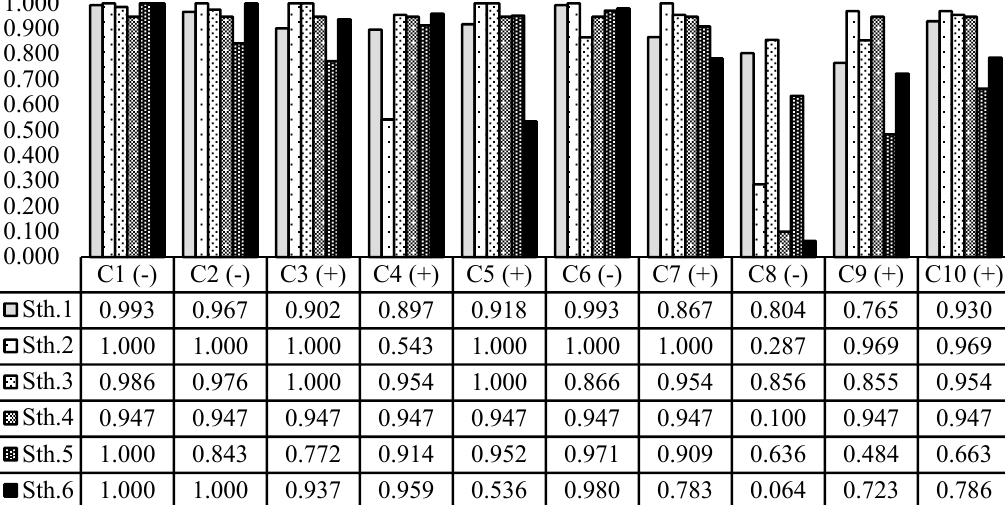
Figure 7. The defuzzified weights of the selected criteria in each individual stakeholder’s viewpoint.